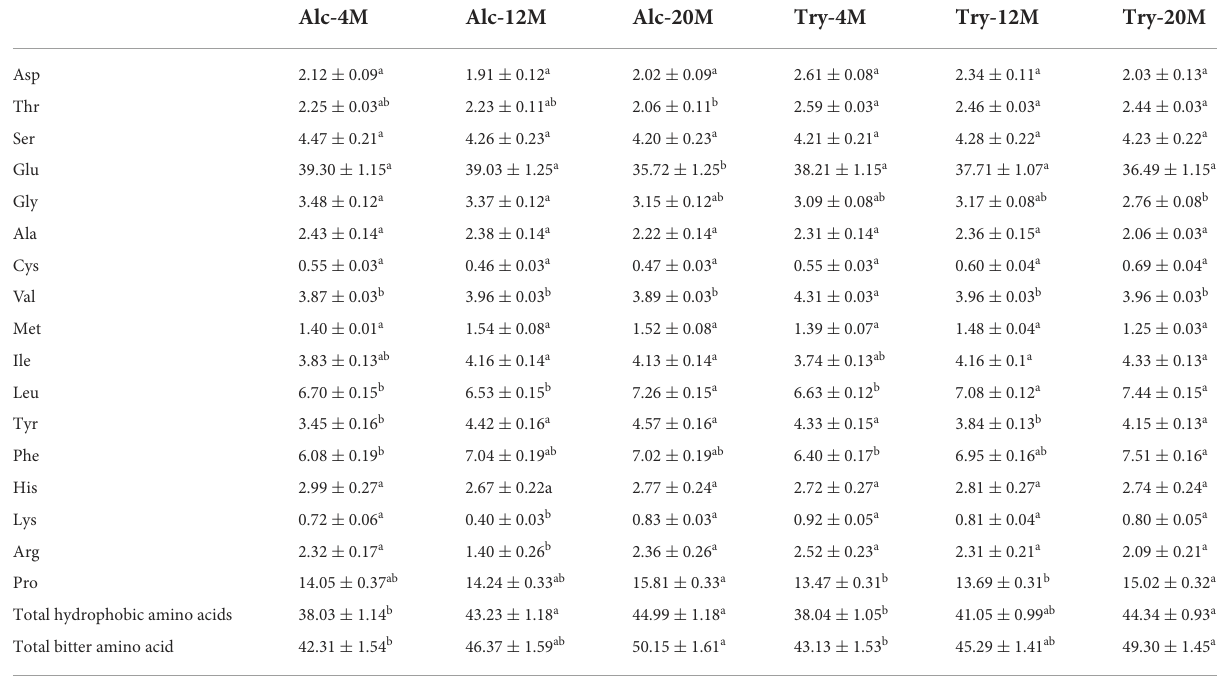
TABLE 1 Amino acid composition of macroporous adsorption resin extracts.